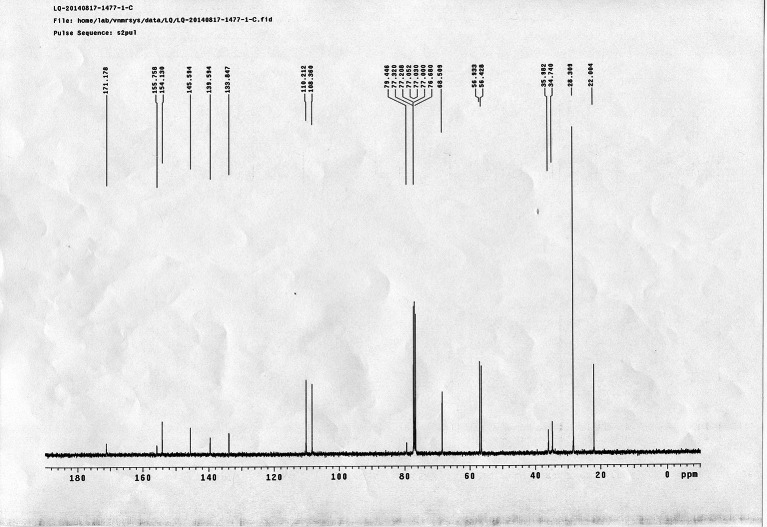
13C NMR spectra of compound 6.